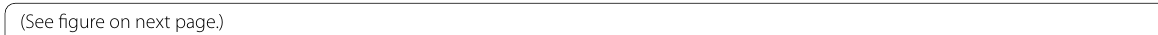
Fig. 5 Representative profiles of the static accumulation of ambient aerial deposits onto the monitor coupons (Nos. 1–12, including STA1, SFA2, and VAB): a sodium (Na) and total organics, b potassium (K) and ionized chloride (Cl − ), c zinc (Zn) and sulfate (SO 42 − ), and d calcium (Ca) and ionized nitrate (NO 3 − ). e Principal component loading using the correlation matrix (Table 5) of the major components in the static monitoring data of CPS1-12 ( n 10) and CAS1-12 ( n 10), as shown in Table 6. Aluminium was used for storage and packaging of the samples, which may have = = resulted in higher